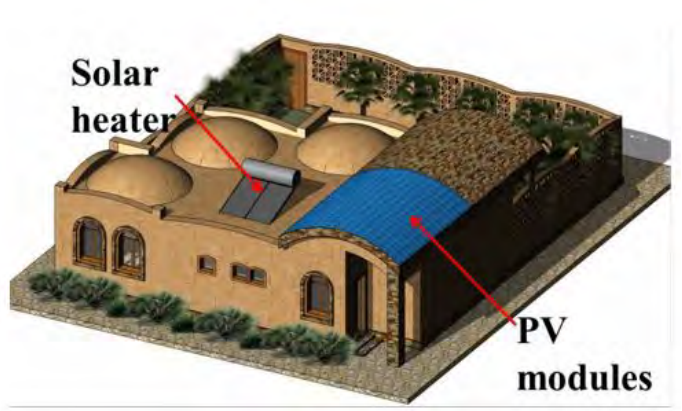
Figure 4. Renewable energy resources in the one story prototype house